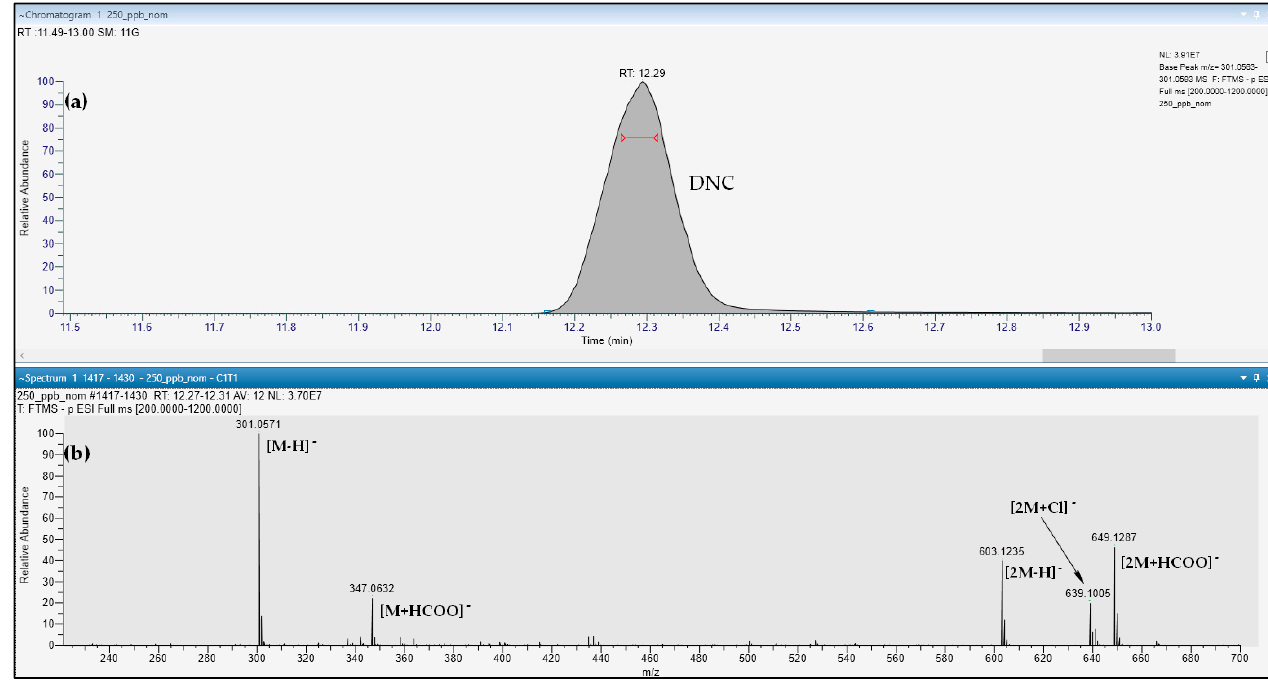
Figure 5. Chromatogram of [M-H] − adduct of DNC ( a ) and the full scan spectrum ( b ) of a standard solution at 250 ng mL − 1 .